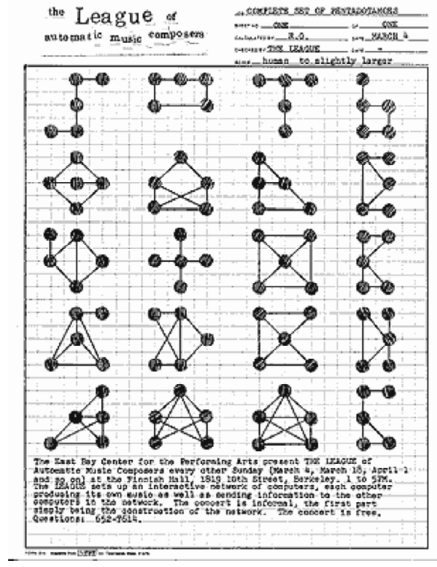
Figure 3 | Image of a flyer designed by Rich Gold from 1979 showing different network topologies between computers (referenced from Barbosa,